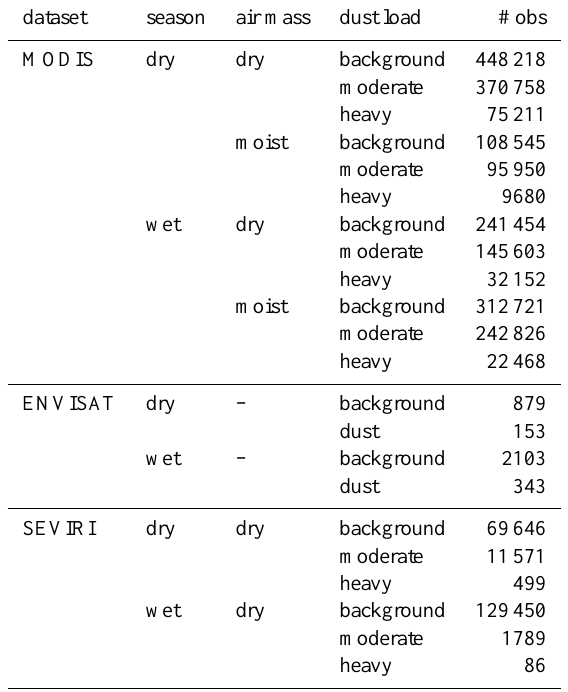
Table 1. Numbers of observations (# obs) within the respective subsets for the three different satellite datasets, separated by season (all) and air mass (MODIS and SEVIRI).